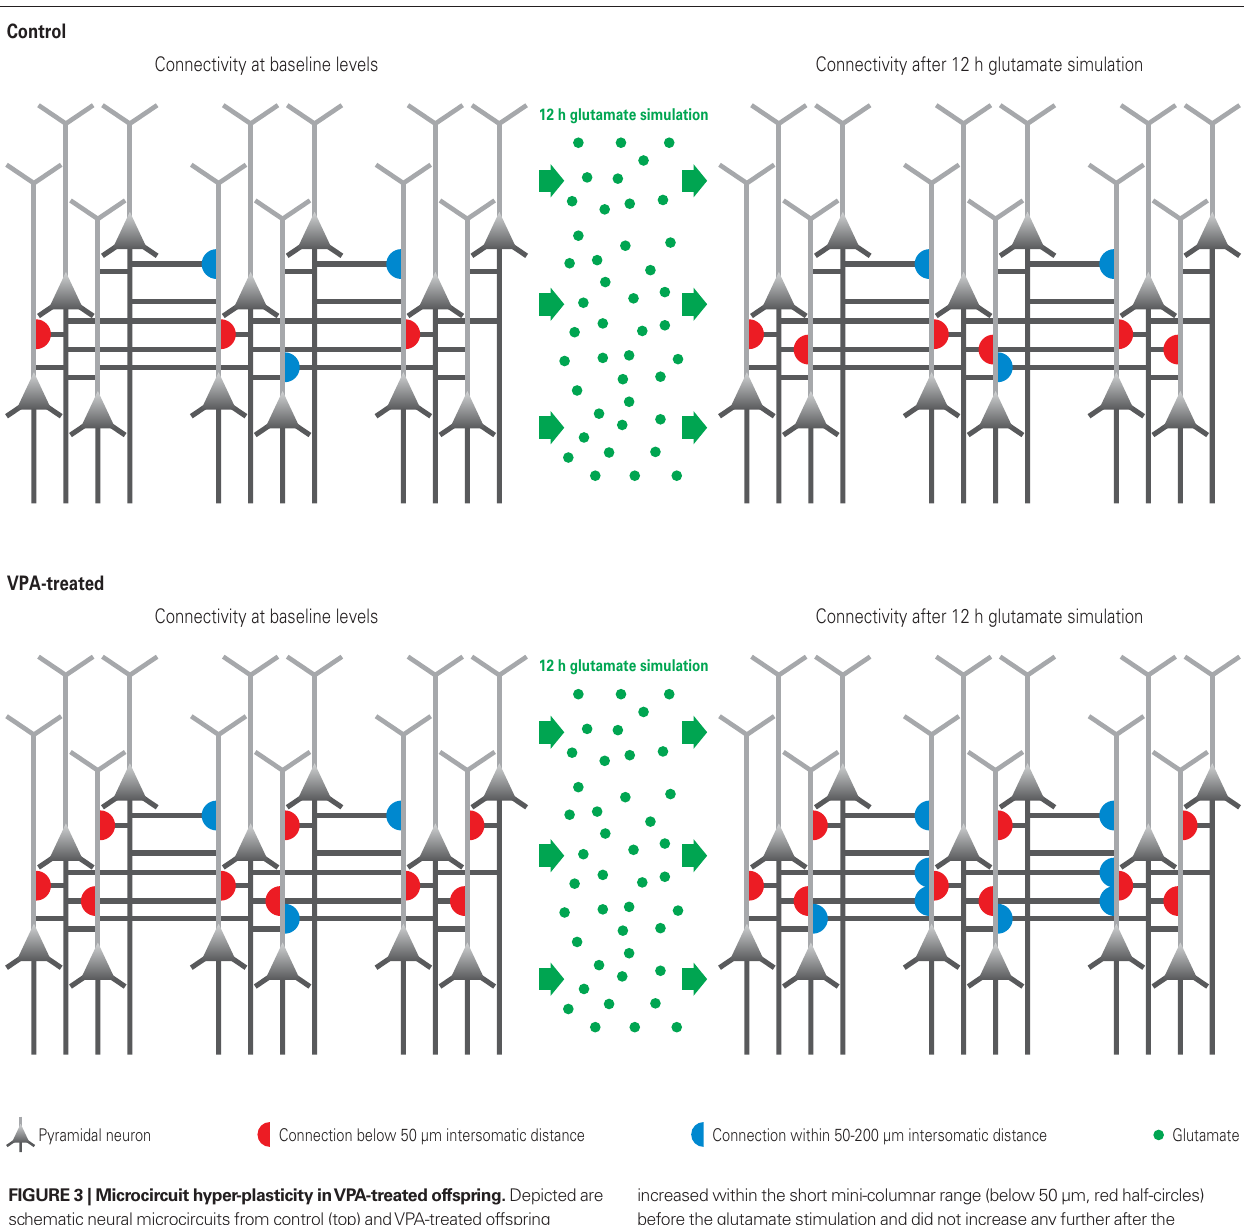
Figure 3 | Microcircuit hyper-plasticity in VPA-treated offspring. Depicted are schematic neural microcircuits from control (top) and VPA-treated offspring (bottom). In this experiment, brain slices were perfused for 12 h with a glutamate solution in order to stimulate the circuits and induce rewiring of connections (red and blue half-circles). The connectivity probability between neurons was accessed before (left panels) and after (right panels) the glutamate stimulation. In controls, the connection probability increased significantly within a range of less than 50 μm (red half-circles), which is the mini-columnar range, but did not change in ranges higher than 50 μm (measured up to 200 μm, blue half-circles), which is a columnar range. In VPA-treated offspring, the connections probability was already